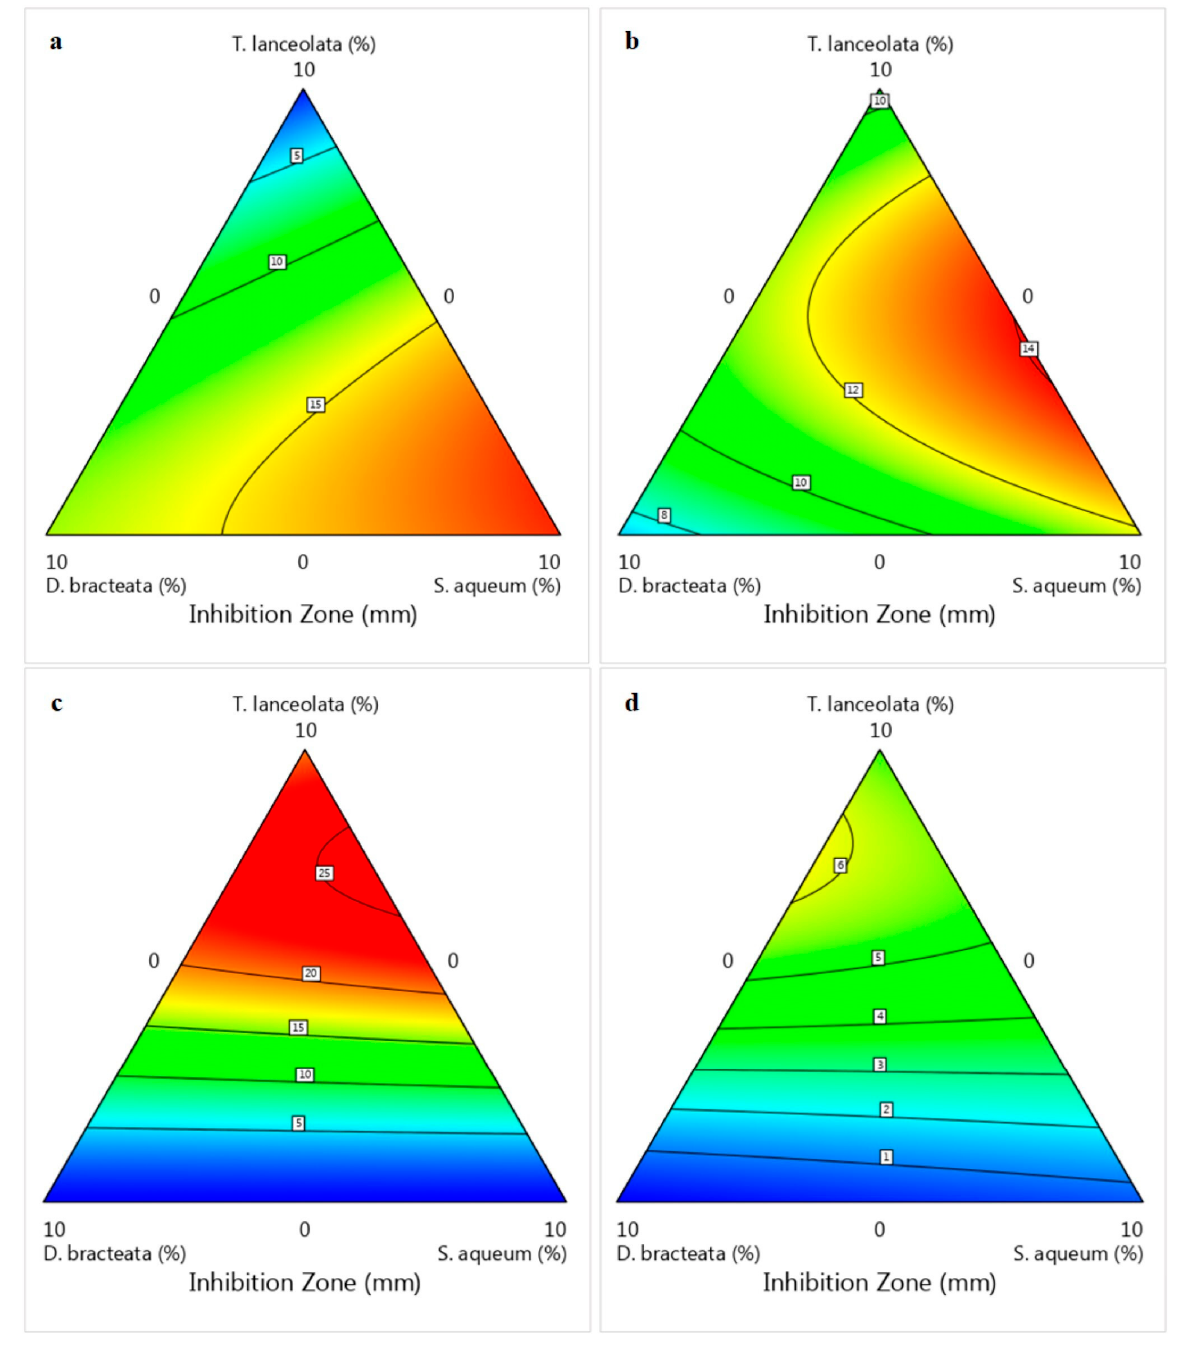
Figure 2. Contour plots for the inhibition zone of extract blends against Pseudomonas viridiflava (( a ); ), Bacillus subtilis (( b ); ), Rhodotorula diobovata (( c ); ) and Al- ternaria alternata (( d ); ) as a function of independent factors (Simplex–Lattice design).